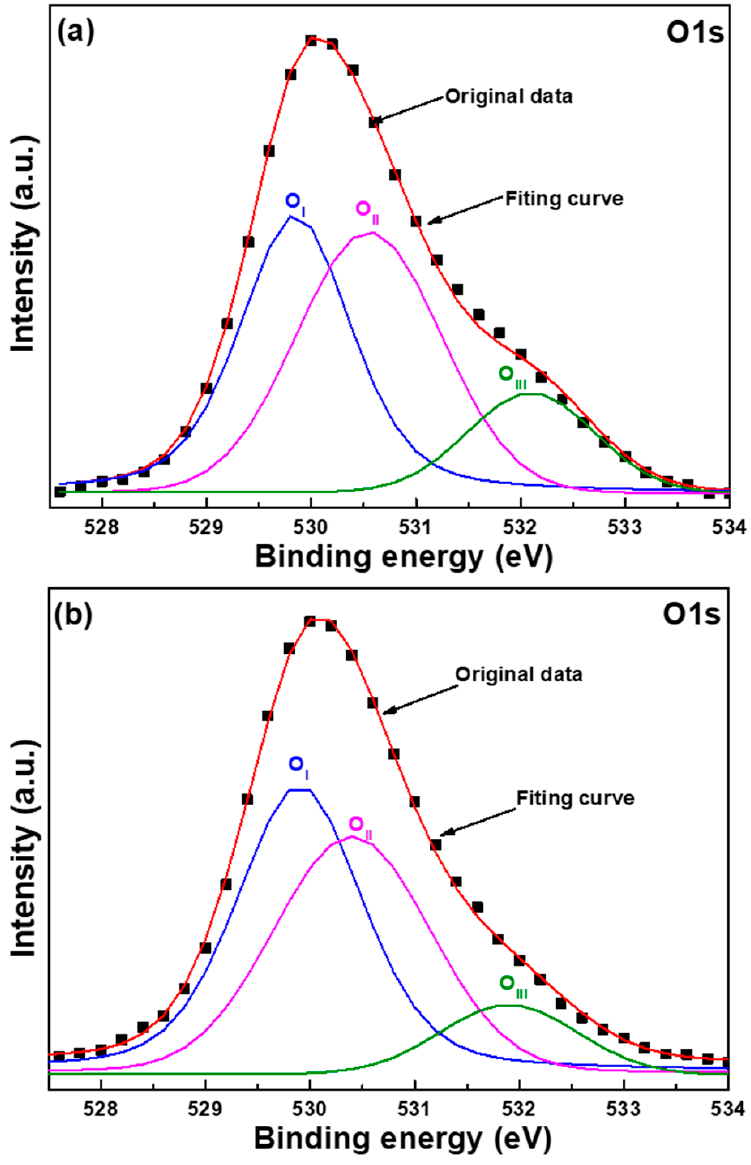
Figure 13. The drawings of O 1s peak of the ZnO nanoflower arrays using different substrates and Al sacrificial layers of ( a ) 120 nm and ( b ) 720 nm.